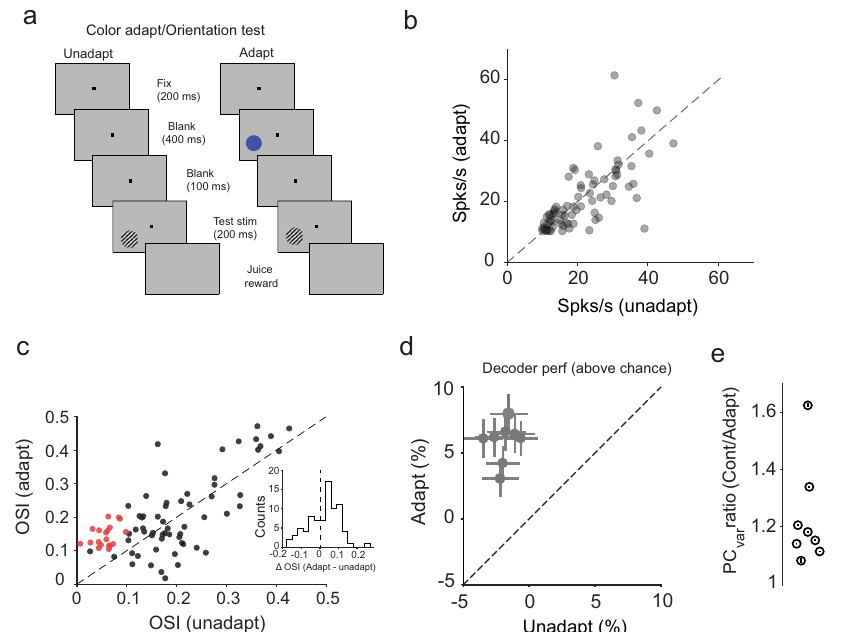
Fig. 4 | Cross feature color adaptation effects. a Schematic description of experimental design in case of cross feature color adaptation (color adapt/orien- tation test). b Mean peak responses of neurons ( n =80) to oriented stimuli for adapted and unadapted trials. Each gray circle represents a single neuron. c Orientation selectivity index (OSI) for neurons in adapted and unadapted con- ditions. Red circles represent neurons that were untuned to orientation in the unadapted condition but gained signi fi cant tuning after color adaptation; black circles represent all other neurons. Inset shows the distribution of change in CSI values (adapt – unadapt, Δ CSI mean = 0.02) calculated for all neurons. d Mean